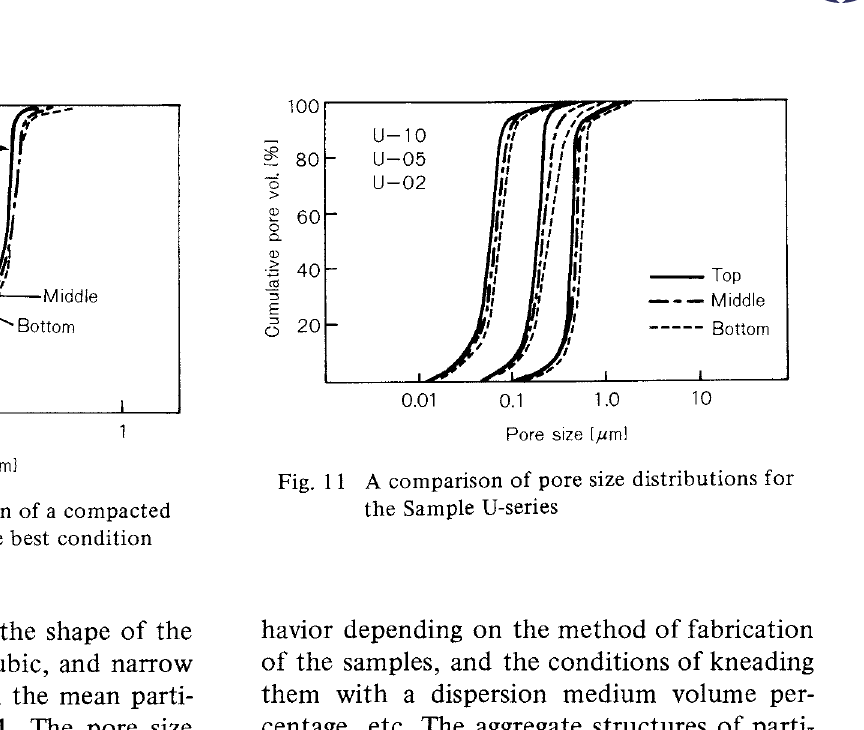
Fig. II A comparison of pore size distributions for the Sample